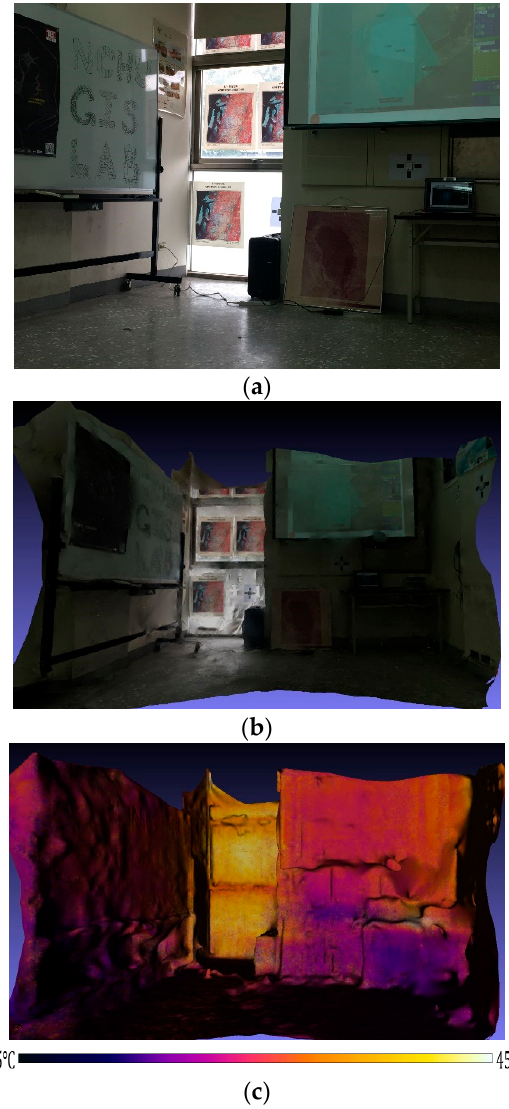
Figure 8. Model reconstruction of medial scale scene: ( a ) visible image of classroom scene; ( b ) 3D model of classroom scene; ( c ) 3D thermal model of classroom scene.